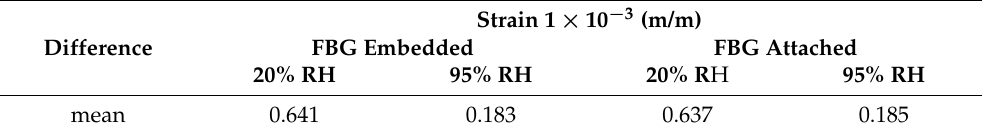
Table 11. Comparison of the strain curves for both materials after exposition on sub-zero temperatures.